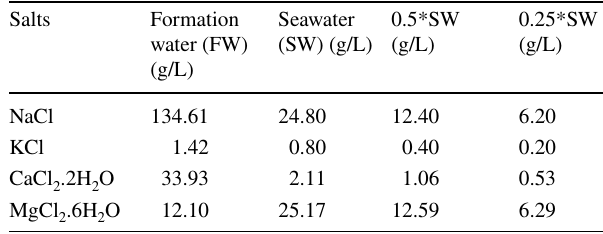
Table 1 Composition of synthetic brines